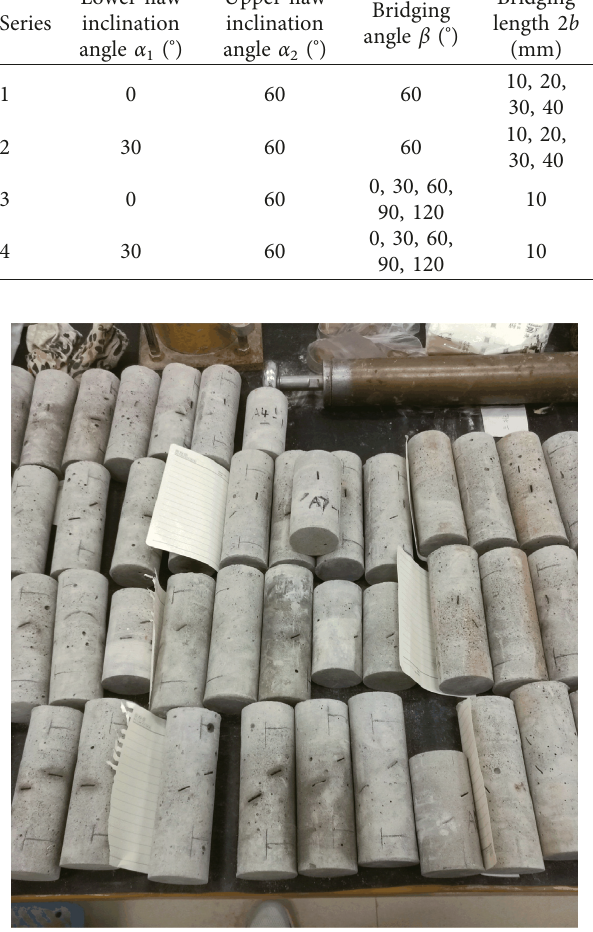
Figure 2: Prepared specimens with two unparallel flaws.